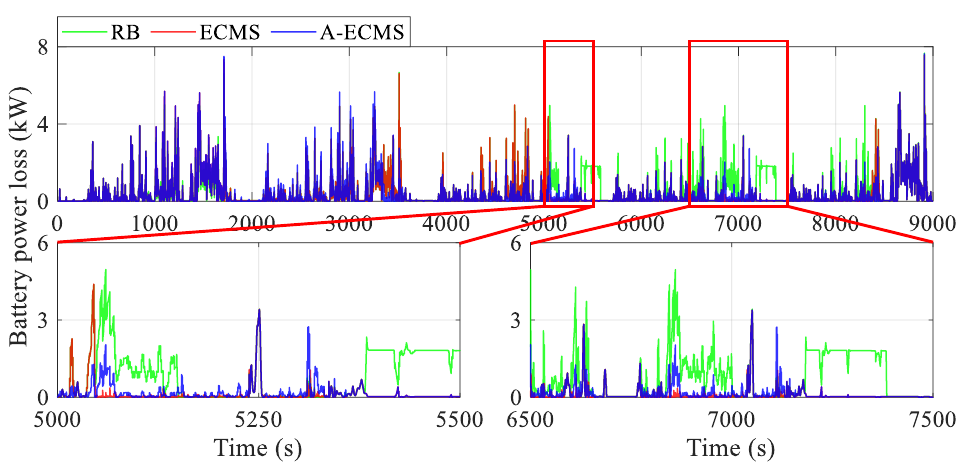
Figure 14. Curves of the battery power loss using different methods.